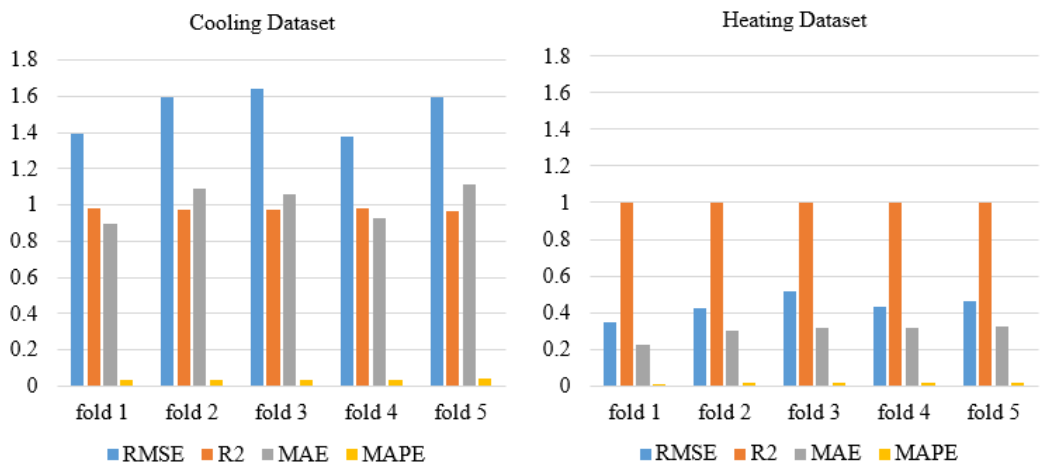
Figure 10. PTA Ensemble Detailed Evaluation Metrics Results Summary for the Best RMSE Values.